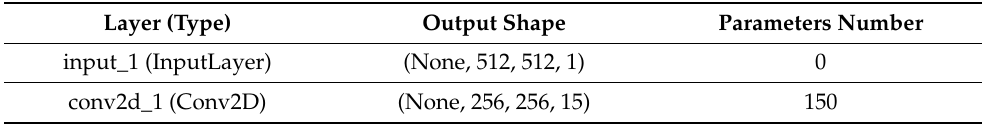
Table 2. The model parameters and shape output after the first hidden layer in the ENet model for a given provided input image (Patient #7 slice